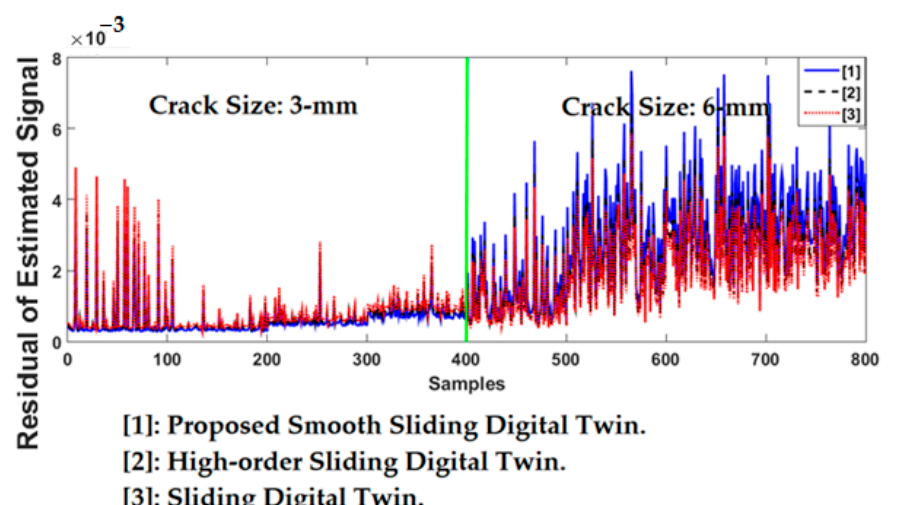
Figure 20. The accuracy of crack size identification for inner-outer residual of RMS signals using proposed smooth sliding digital twin, high-order sliding digital twin, and sliding digital twin.